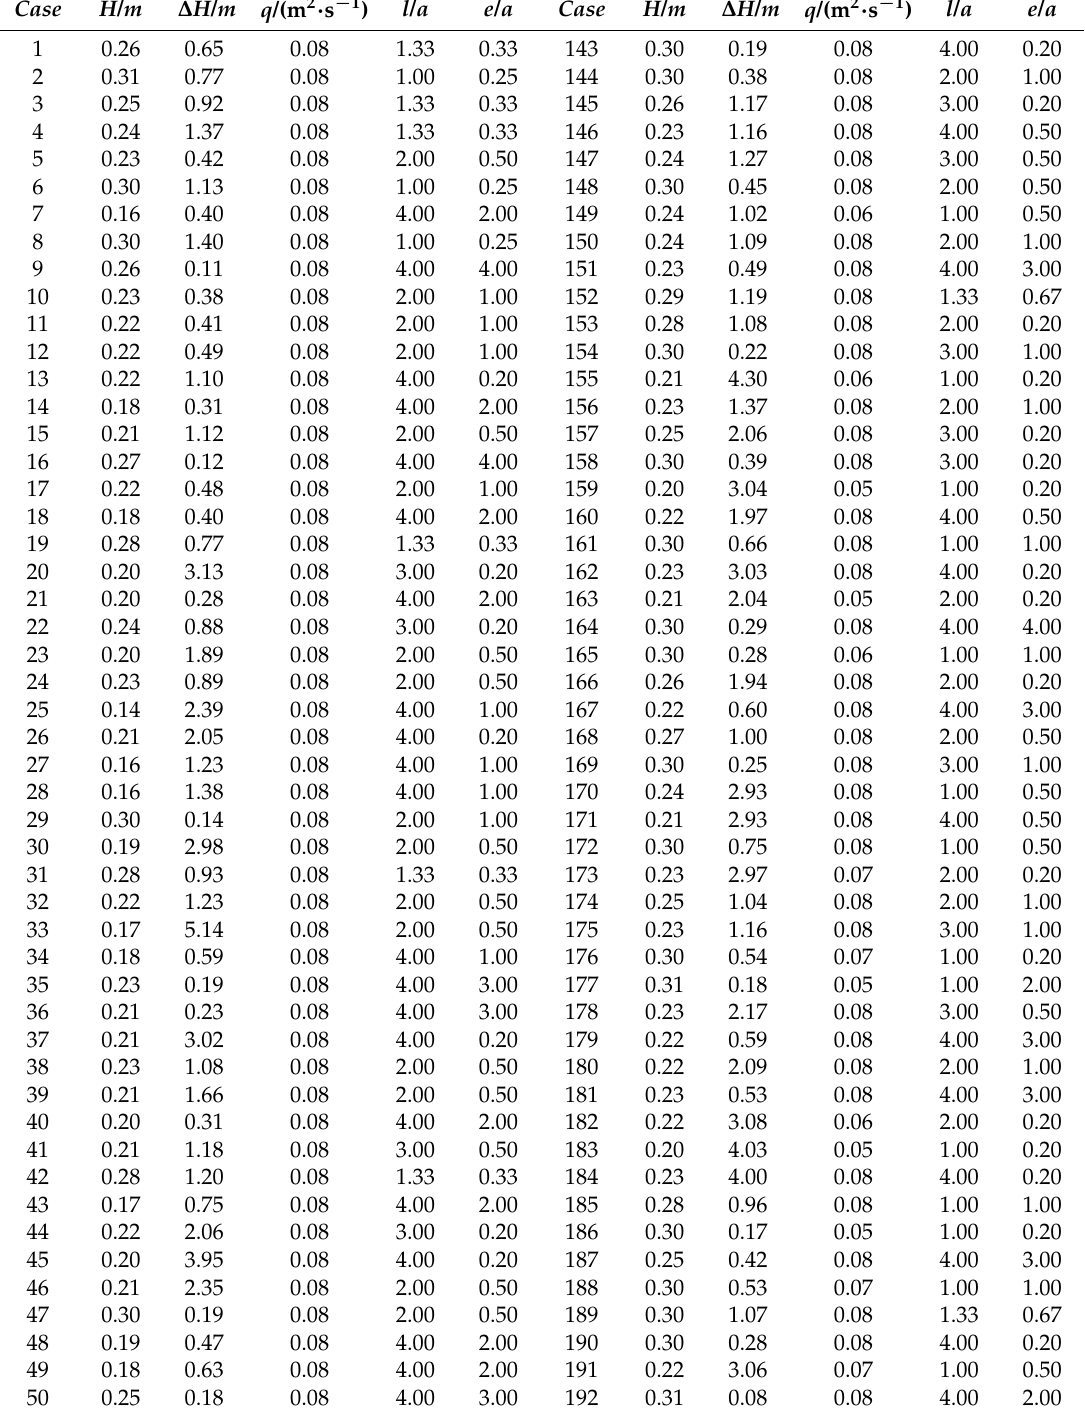
Table A1. Experimental data for calculating the discharge coefficient of combined orifice-weir